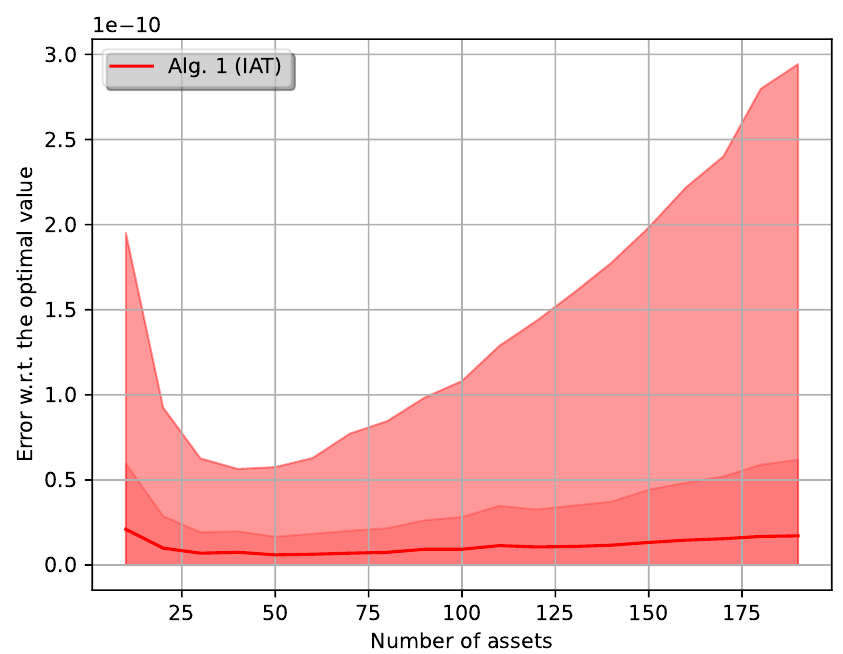
Figure 4. Graph of the error of Algorithm 1 with respect to the number of assets in the market. The center lines represent the average on 1000 thousand tests. The inner shaded area represents the standard deviation around the average. The borders of the outer shaded area represent the maximum and minimum